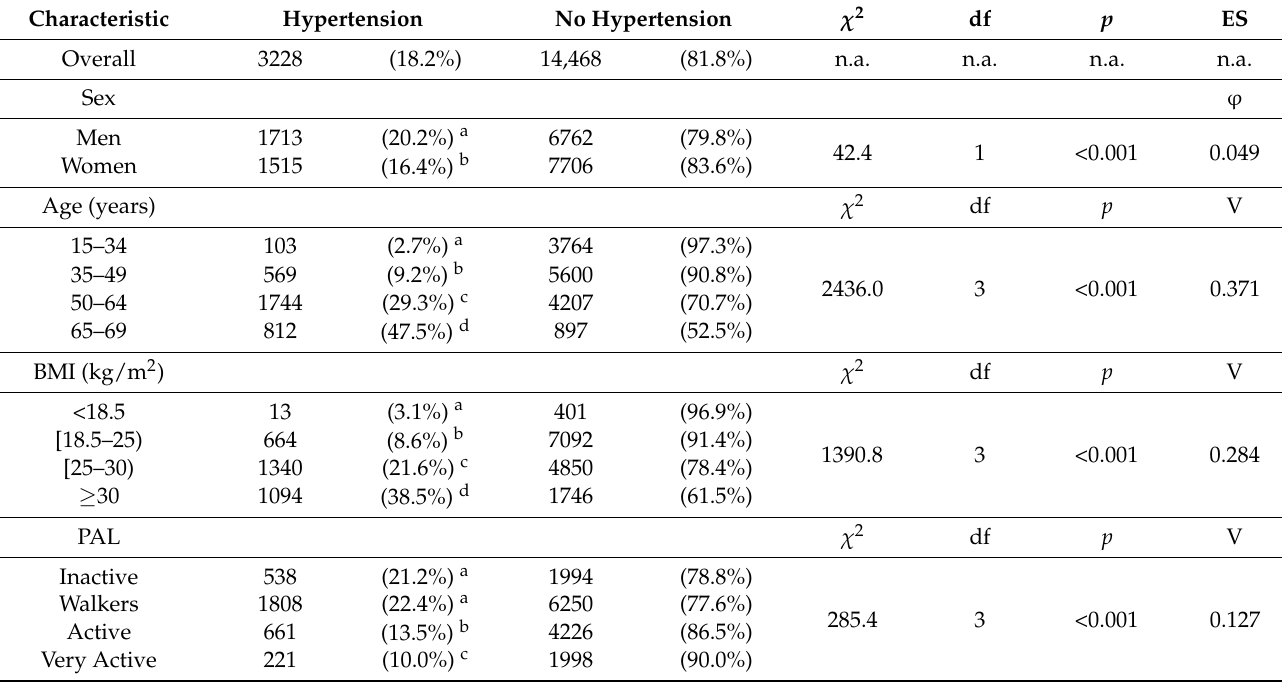
Table 2. Population characteristics by hypertension status in Spanish 15–69-year-olds in SNHS2017 (data presented in absolute and relative